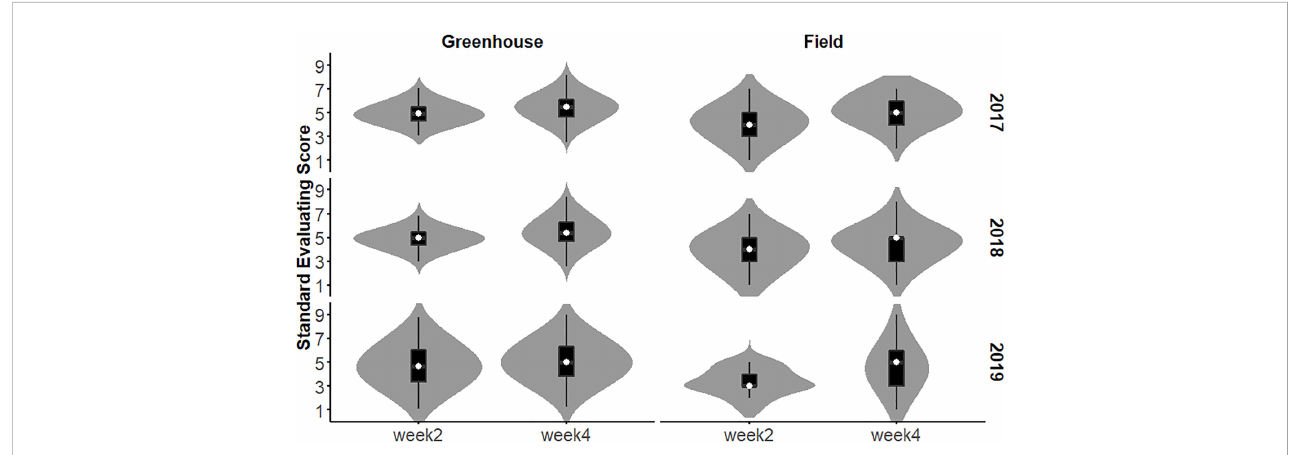
FIGURE 3 Distribution of RIL SES under greenhouse and fi eld conditions from 2017 to 2019.